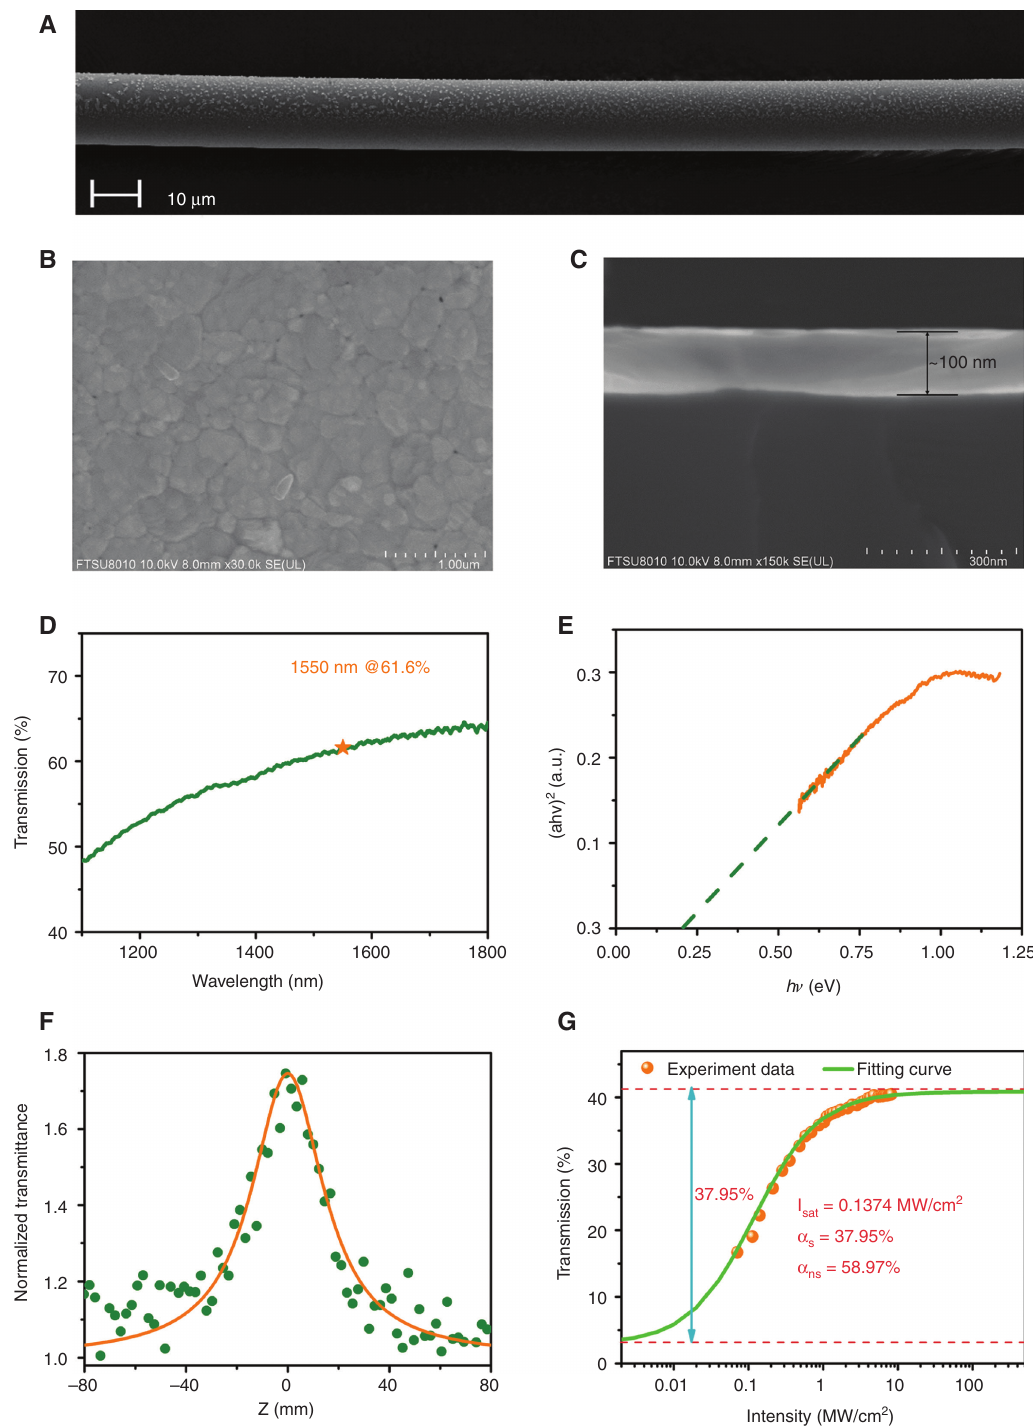
. Figure 1: Characterization and nonlinear characteristics of WTe 2 (A) SEM image of WTe -coated microfiber, (B) surface morphology, (C) vertical thickness, (D) linear absorption spectra, (E) Tauc plot, 2 (F) OA Z-scan, (G) power-dependent absorption of WTe 2 and data recording. The length of the whole ring cavity is cross section. The ISO is used for guaranteeing orderly 2.98 m, which contains the EDF of 0.58 m and single-mode unidirectional laser transmission. A small portion of the fiber of 2.25 m. light is exported by a 20:80 OC for real-time observation